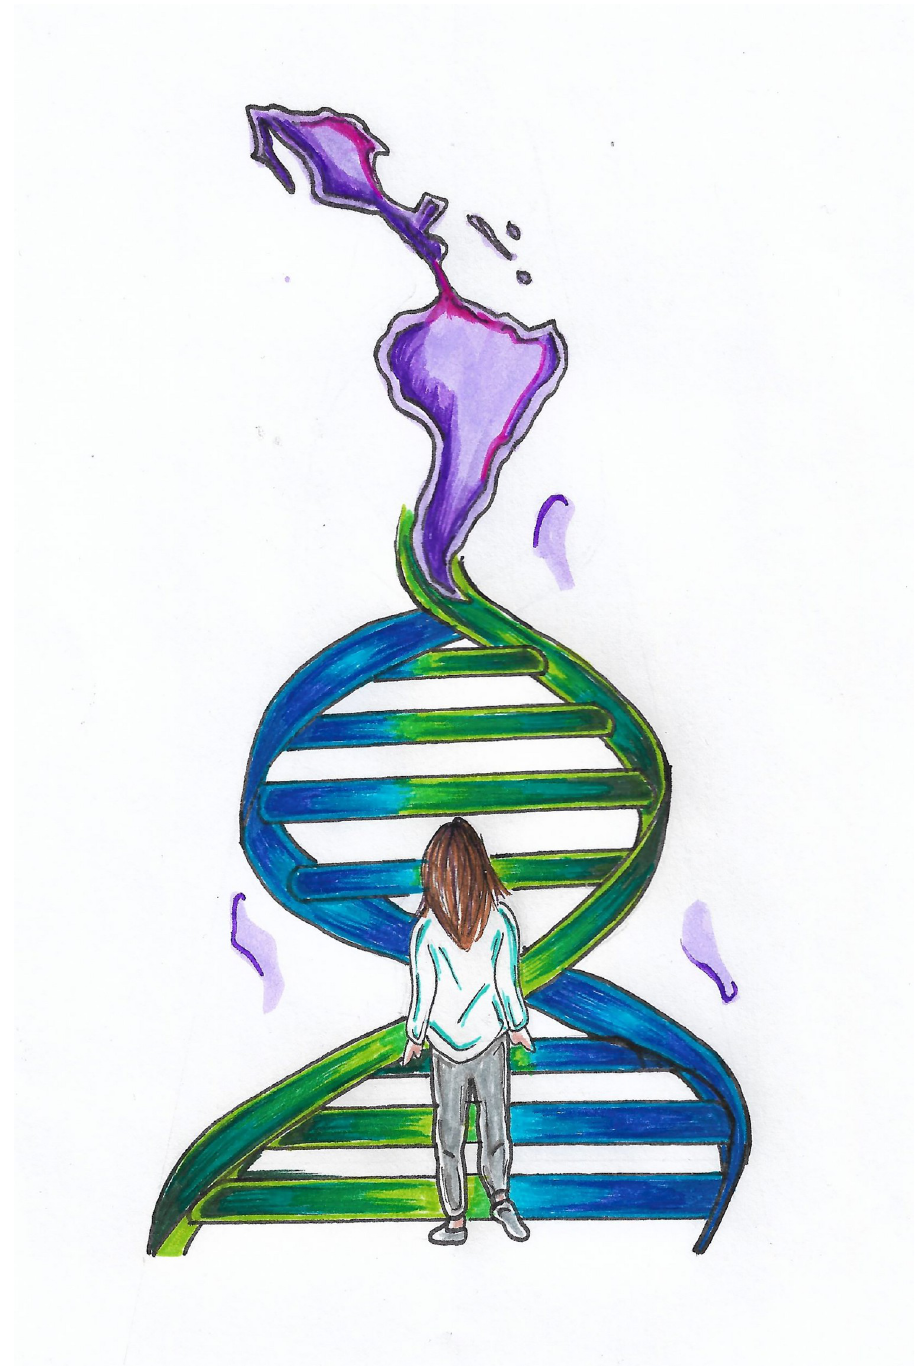
Fig 5. Collaborate with other research groups, organizations, and institutions. Knit educational programs, research, networks, and other international initiatives designed to promote fair and equitable collaboration (Illustrated by Jose Faustino